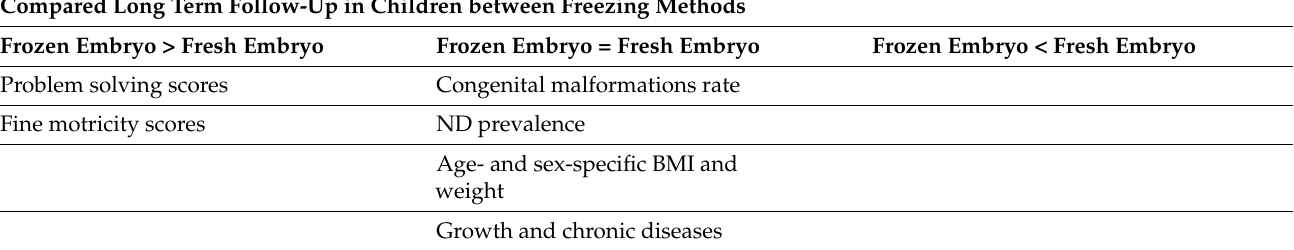
Table 3. Comparison of long-term health aspects in children between frozen embryo and fresh embryo